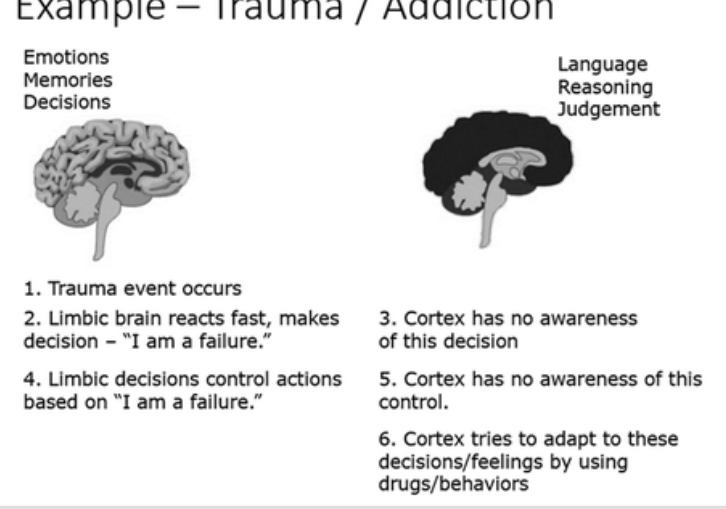
Figure 3. Example of trauma/addiction. The emotions and decisions made by the mammalian brain with trauma take place without awareness of the cortex. As described in the text, the cortex/conscious brain will attempt to manage or respond to these in ways that may lead to addiction.